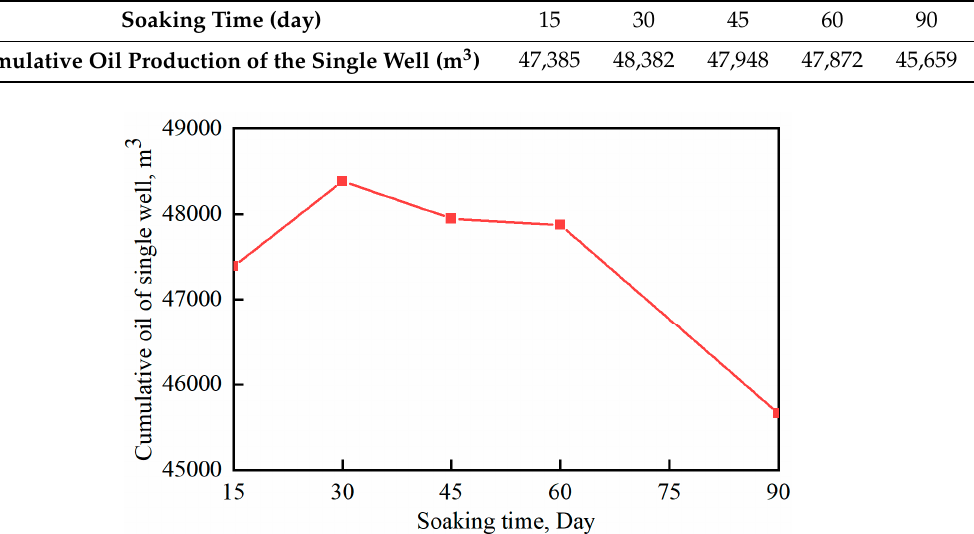
Figure 14. The relationship between cumulative oil production and soaking time in the single well.